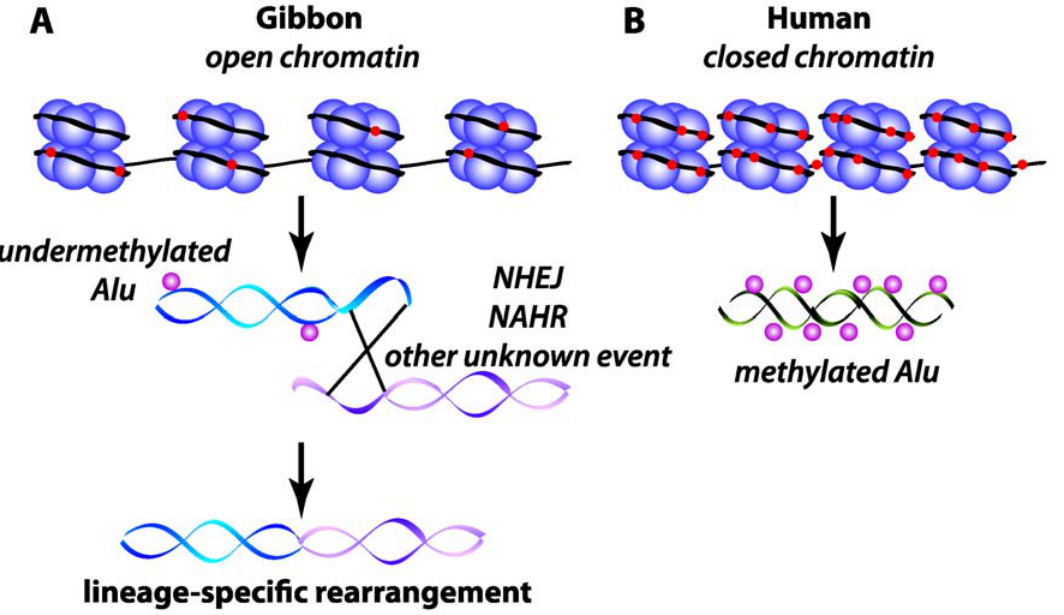
Figure 1. Schematic of epigenetic state of Alu elements at gibbon and human orthologous evolutionary breakpoints. (A) Gibbon breakpoint region containing an undermethylated Alu, resulting in open chromatin, and (B) human orthologous region containing a methylated Alu and closed chromatin. DNA (black) is wrapped around nucleosomes (purple) showing relative DNA methylation levels (red). The possible rearrangement mechanisms are indicated on the affected DNA molecules in the gibbon. NAHR, non-allelic homologous recombination; NHEJ, non- homologous end joining.